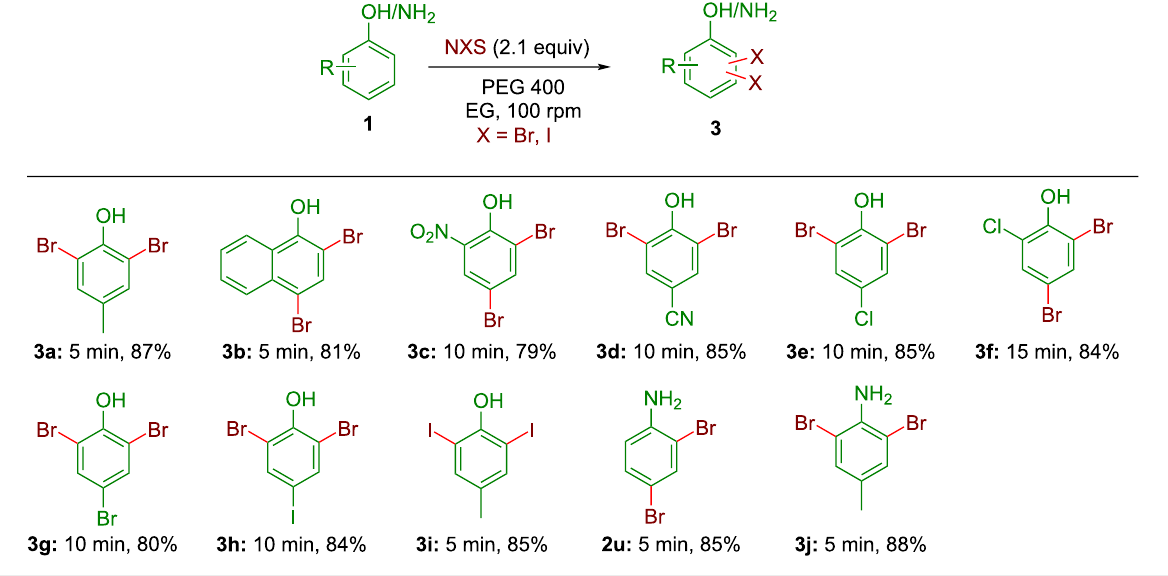
Scheme 4: Dihalogenation of phenols and anilines with NXS by automated grinding. All yields refer to the isolated